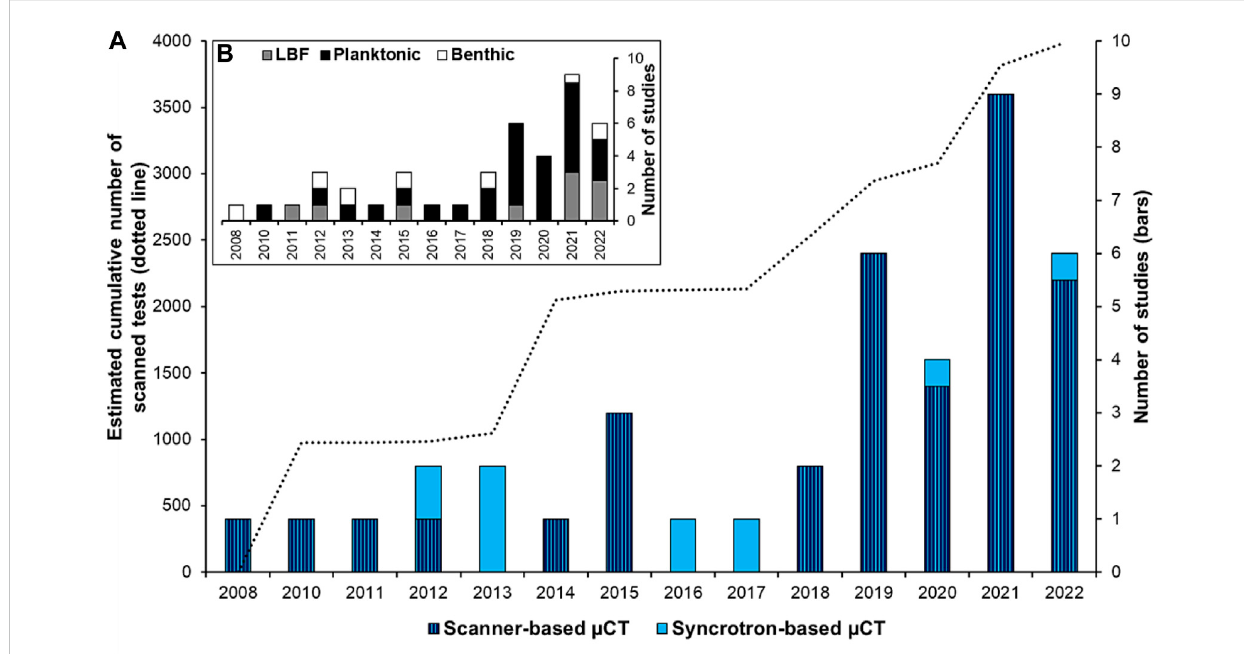
FIGURE 1 (A) Numberofstudiesusing3Dforaminiferareconstructionswithscanner-based(darkbluewithstripes)orsynchrotronlight-basedµCT(lightblue), and the estimated number of specimens scanned (dotted line). (B) Number of studies using planktonic (black), large benthic foraminifera (LBF, grey), and benthic foraminifera (white). References are in Supplementary Table